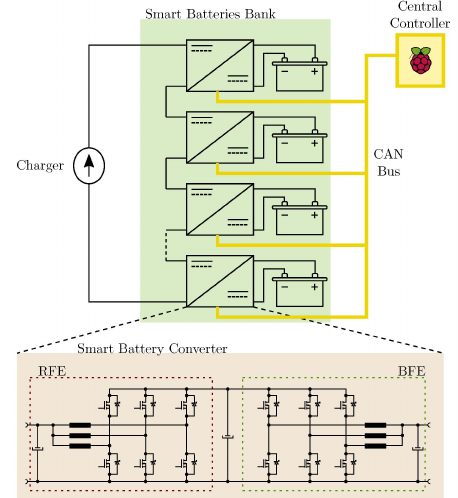
Figure 2. Proposed series cell-to-pack module-integrated bank based on back-to-back